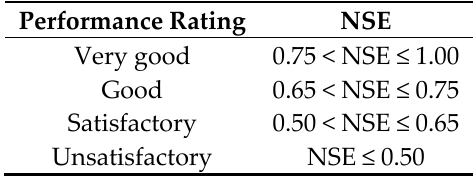
Table 3. General performance rating for the recommended statistics for monthly time step